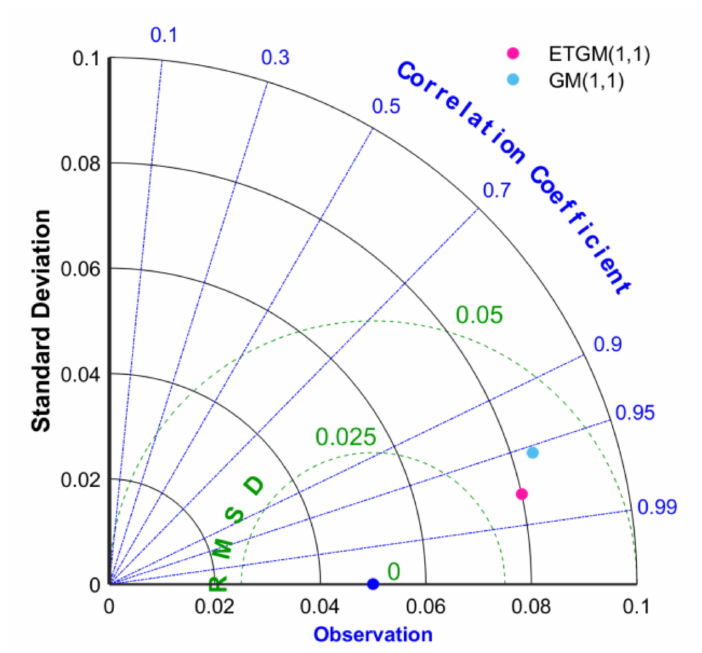
Figure 8. Accuracy comparison of GM(1,1) and ETGM(1,1) using the Taylor